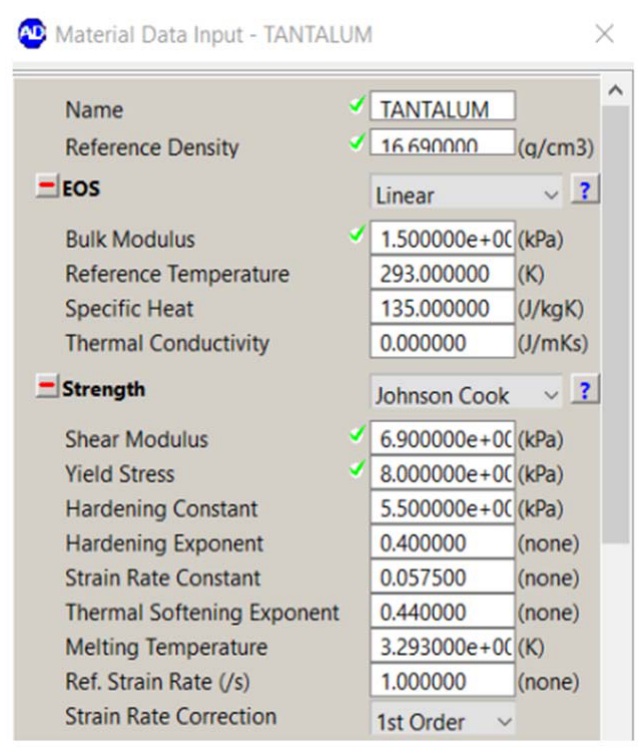
Figure 14. Characteristics of tantalum used in numerical simulation (Autodyn) [8] Tantalum is a material of relatively high density (16690 kg/m 3 ); because of its high density, tantalum